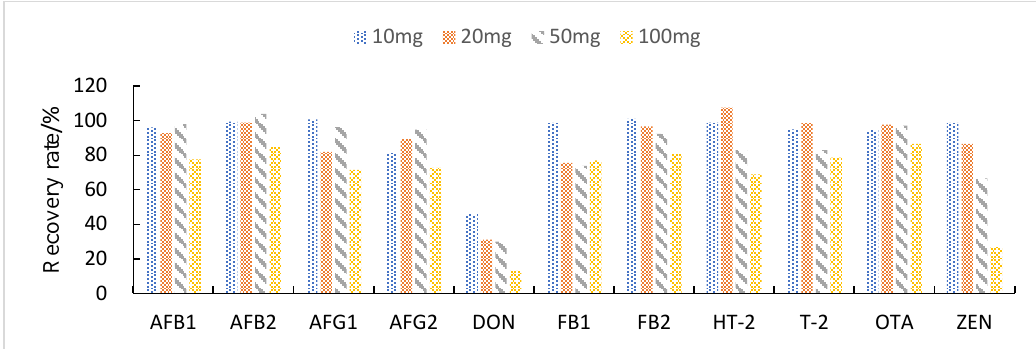
Figure 5. Effect of different Esela ® HLB additions on the recovery of 11 fungal toxins.